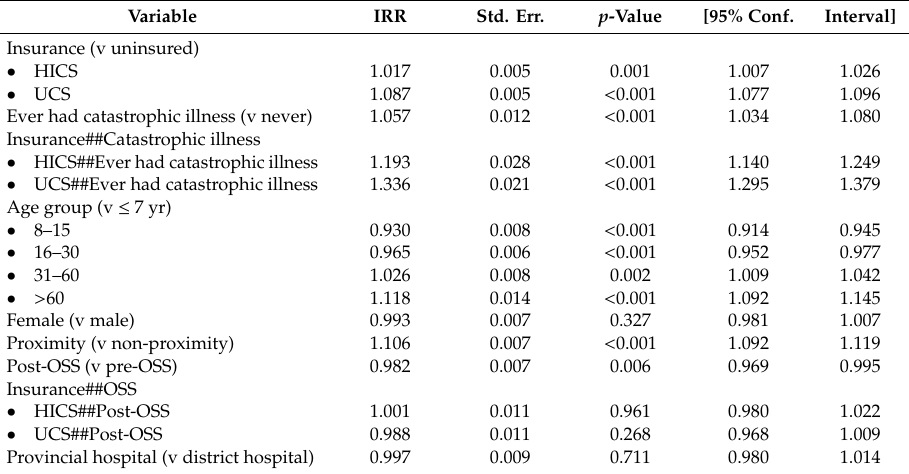
Table 2. Multivariable analysis of IP utilisation volume by the Poisson regression with interaction terms.